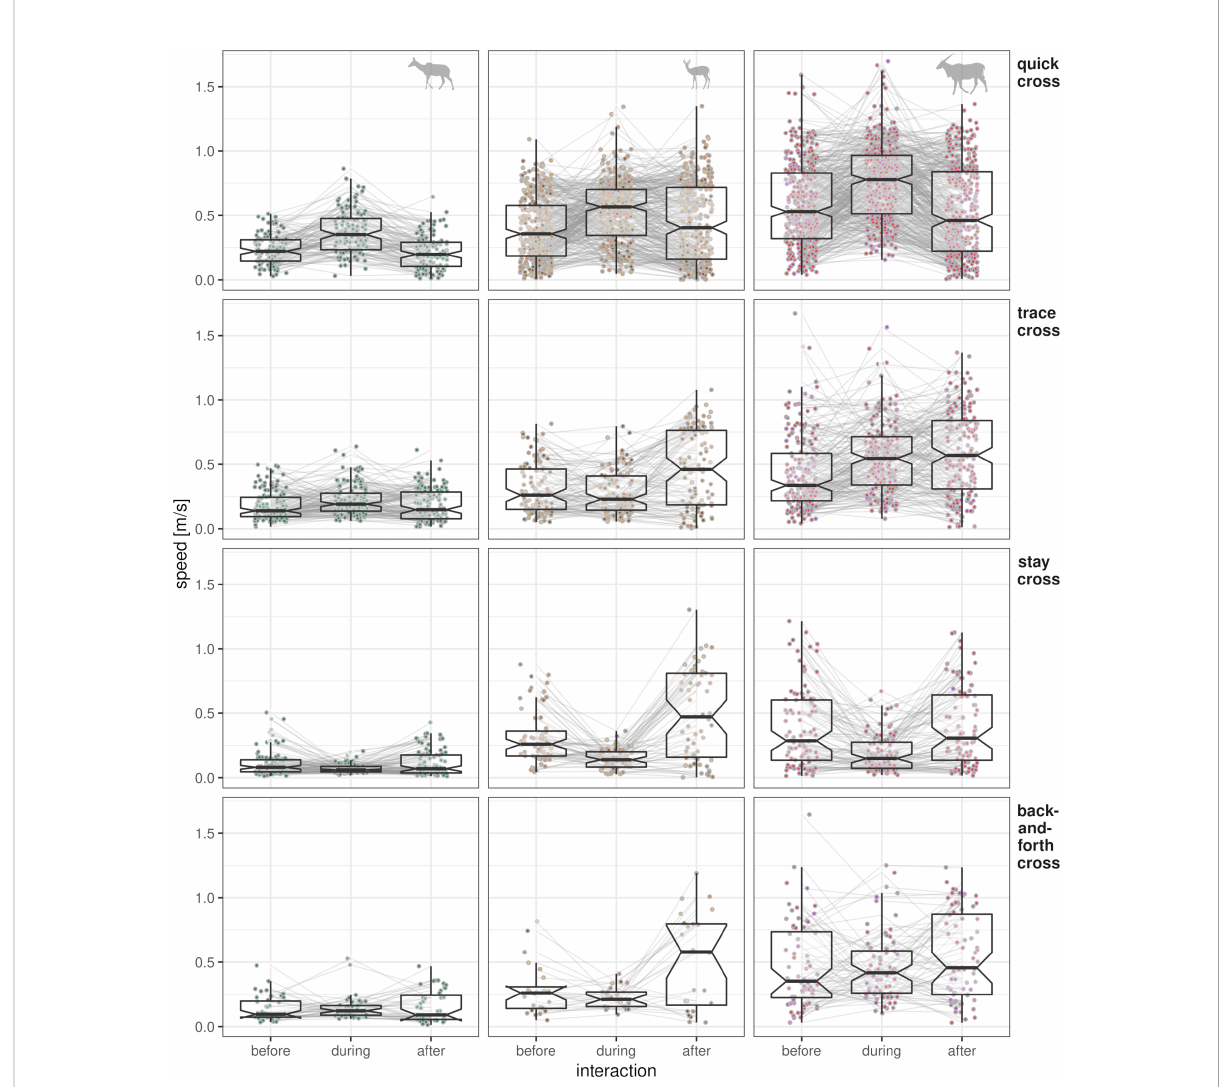
FIGURE 10 Average speeds of crossing fence interactions. Speeds are averaged per interaction event and temporal group (all speeds 45 min before , 45 min after and all speeds during the interaction) with box – whisker plots (no outliers shown, con fi dence region indicated by notches). Speeds are on the y -axis and temporal groups are on the x -axis. Single events are connected by a line. Columns of panels refer to species (see symbol in the fi rst row); rows of panels refer to fence interaction type (see row titles on the